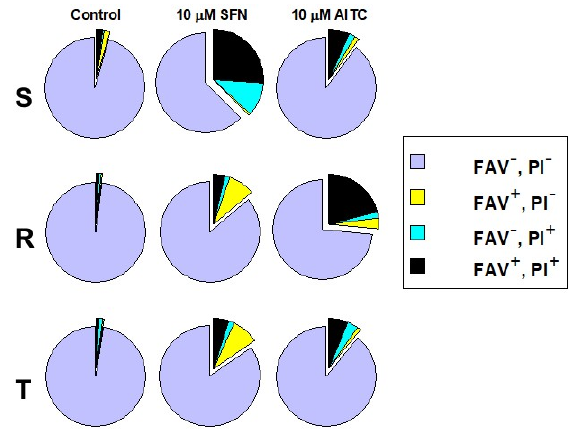
Figure 4. Determination of cell viability by FAV/PI assay. The cells were incubated for 48 h in the absence (control) or presence of 10 μ M of either SFN or AITC prior to the measurements. Legends: FAV − , PI − –viable cells; FAV + , PI − –apoptotic cells; FAV – , PI + –necrotic cells and FAV + , PI + –cells in late state of death. Data in the pie charts are representative of three independent measurements. Respective FACS dot plots are documented in Supplementary files (Figure S1).